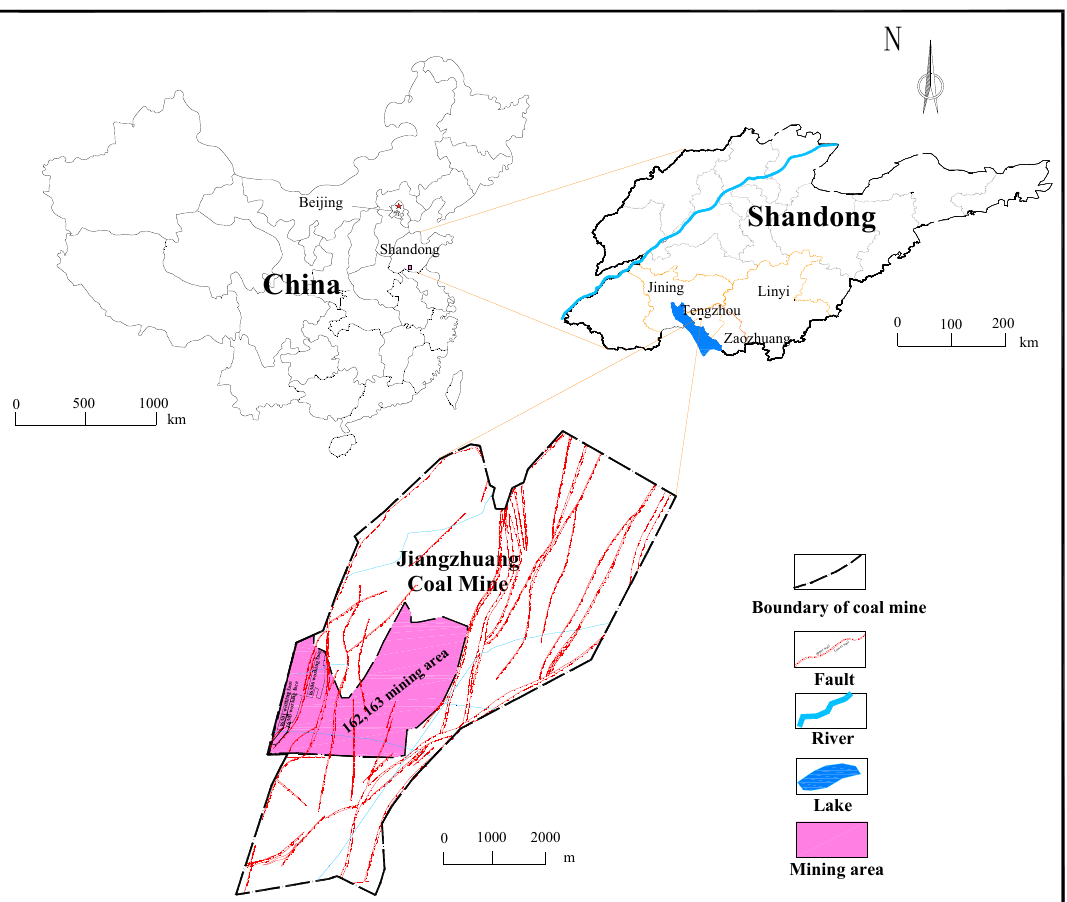
Figure 1. 162 and 163 mining area location diagram